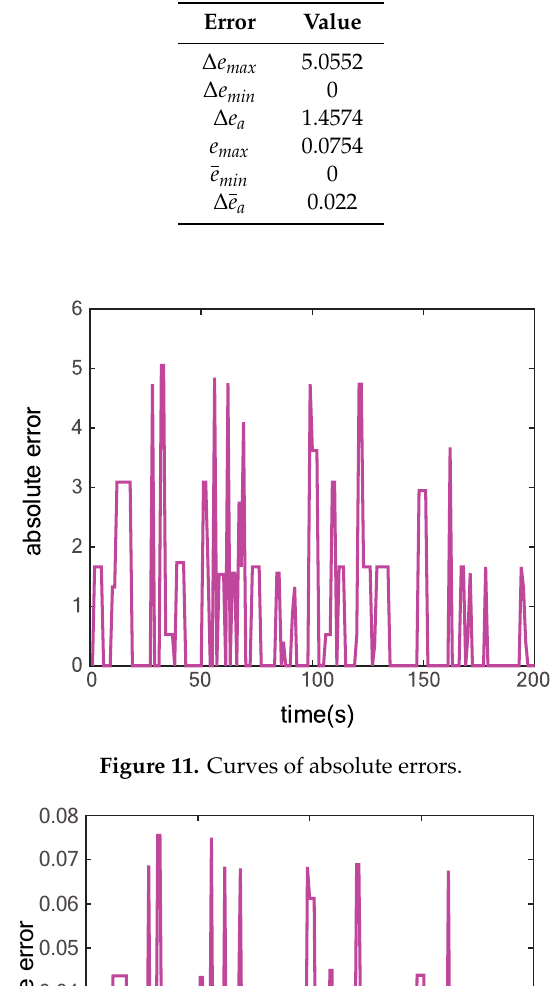
Table 2. Errors between dynamic and static algorithms.